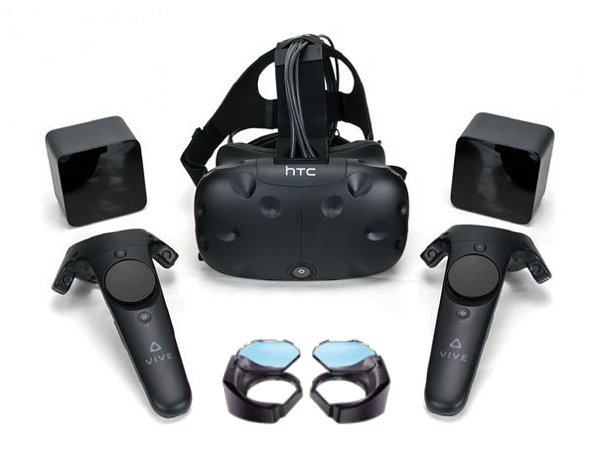
Figure 3: The HMD Vive components with the eye-tracking lenses.